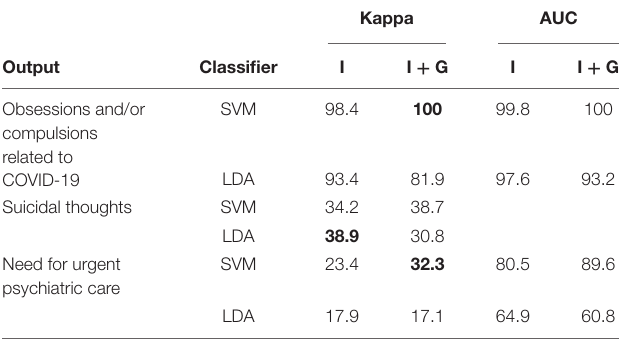
TABLE 4 | Kappa and AUC (only for two-class problems) values, in percentages, yielded by SVM and LDA classifiers with and without gender as input (columns I and I + G, respectively).